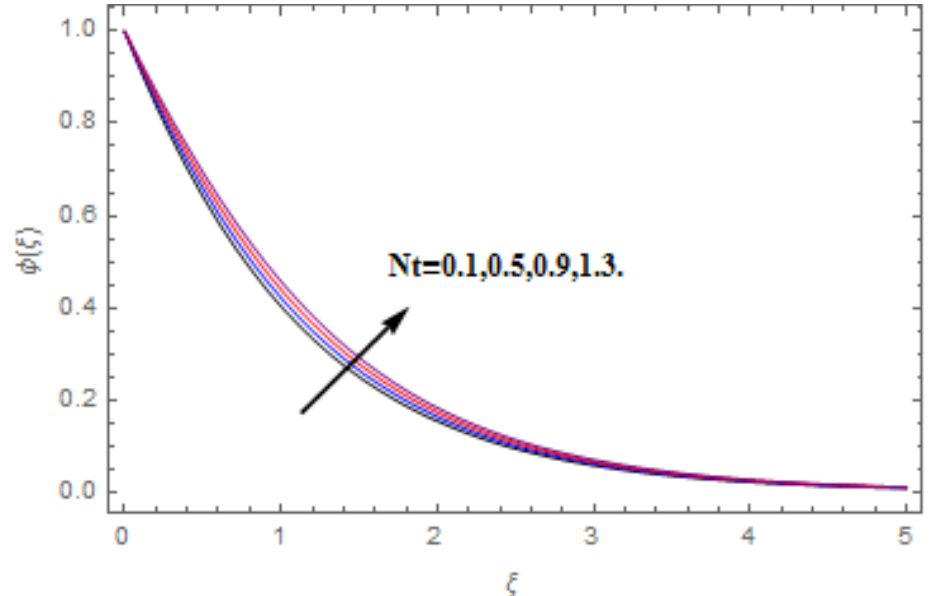
Figure 17. Varation in φ ( ξ ) against Nt , when M = ψ = 0.2, Nb = 0.5, Le = 1.0, Ec = 1.0, Pr = 1.2, γ = 0.1, κ = 1.0. Molecules 2020 , 25 , x FOR PEER REVIEW 16 of 21